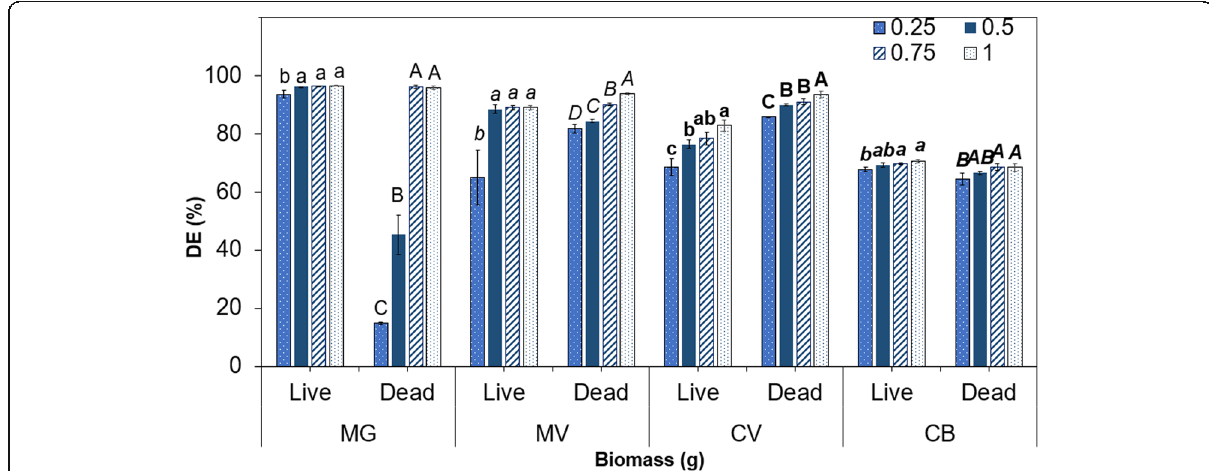
Fig. 6 Effect of biomass concentration of Streptomyces isolate (live and dead cells) on the DE of TPM dyes. Means with the same letters (lowercase, live cells; uppercase, dead cells) and font style (MG, regular; MV, italic; CV, bold; CB, bold italic) are not significantly different at HSD ( 0.05 ). Bars indicate ±